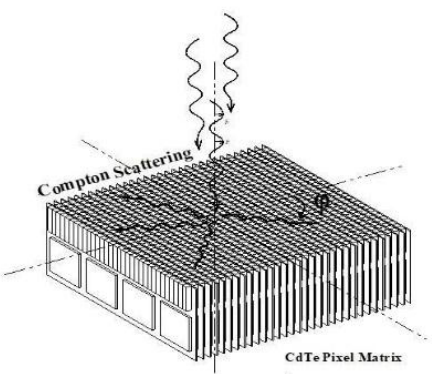
Figure 1. A schematic of a CdTe/CZT segmented spectrometer. The impinging photons can be scattered inside the same sensitive volume. The possibility to determine the interaction position and the energy deposit of photons that hit one of detector sensitive unit and scatter inside a different one allow for measuring the polarization status (i.e., direction and fraction) of the impinging photons.